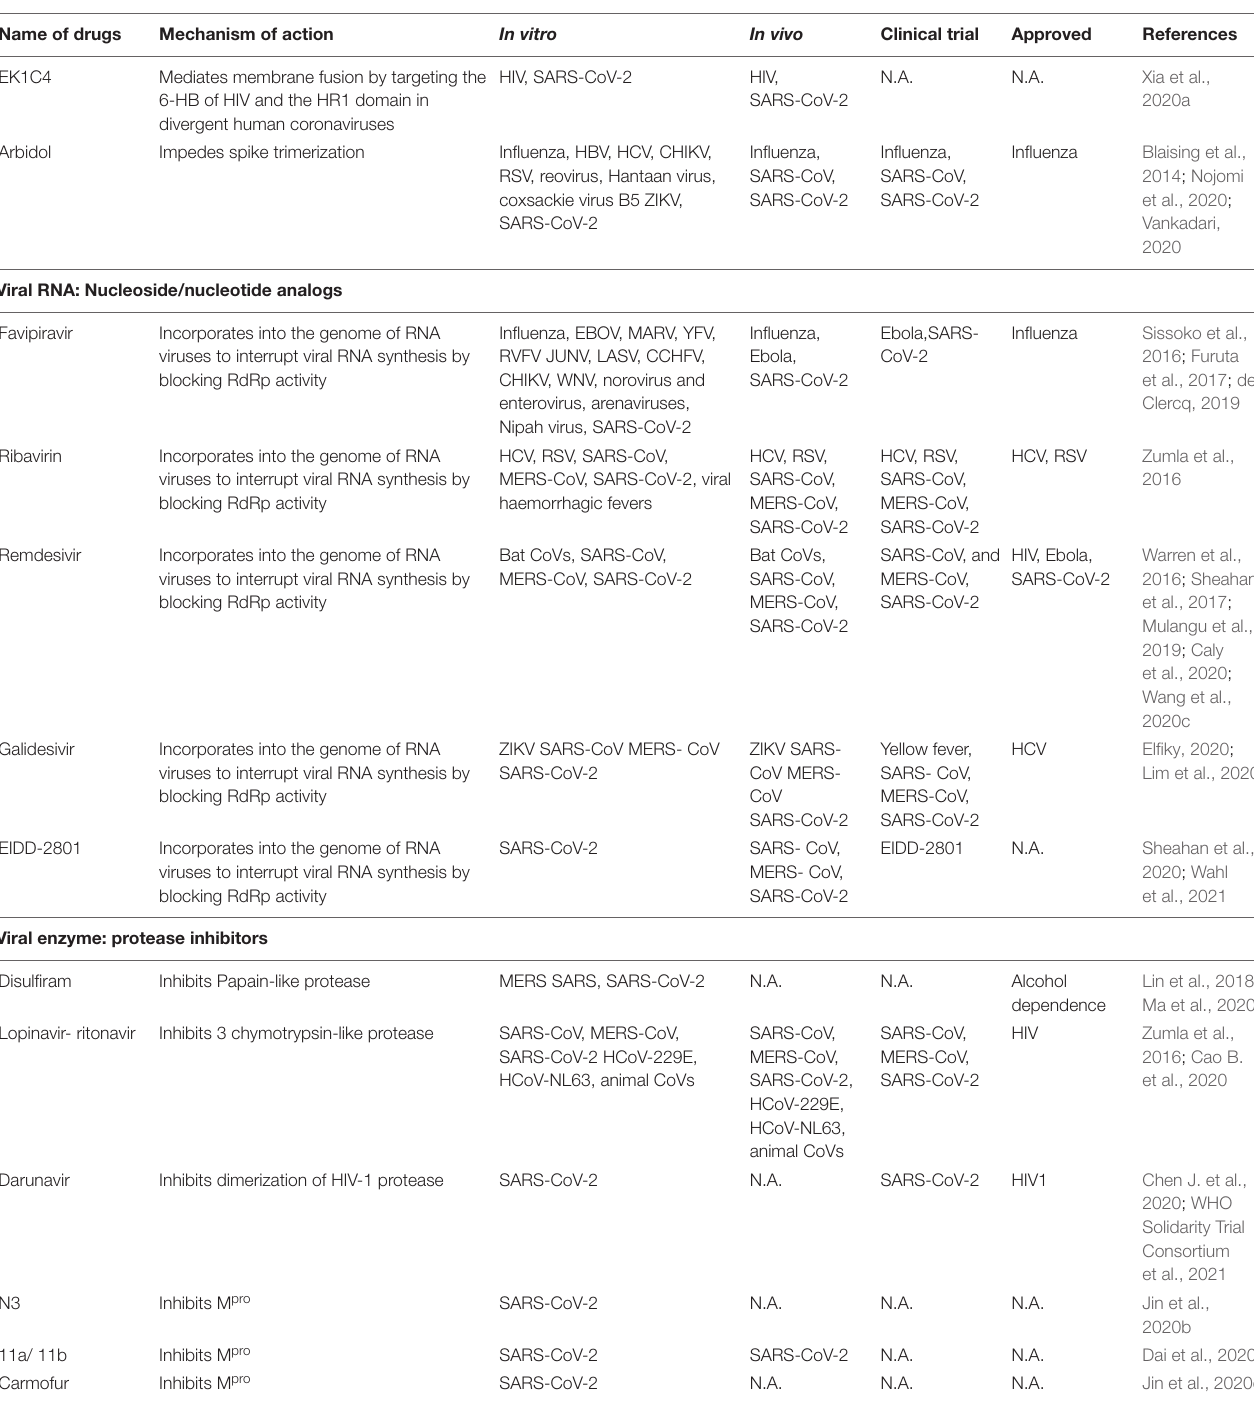
TABLE 1 | Representative direct-acting antivirals for CoV